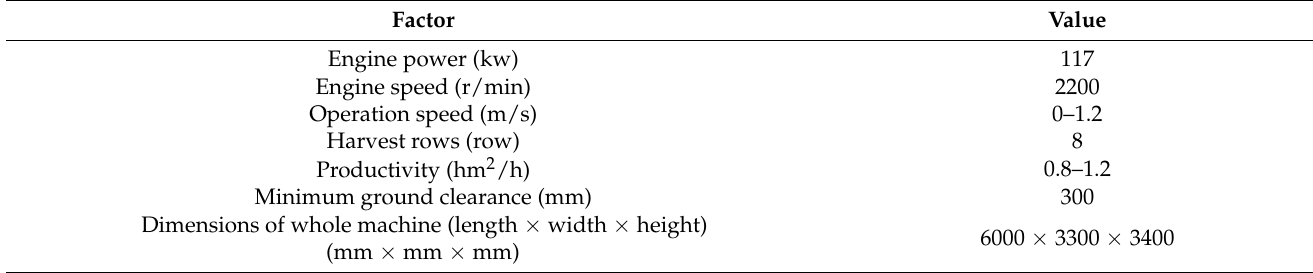
Table 1. Main technical parameters and performance indices.